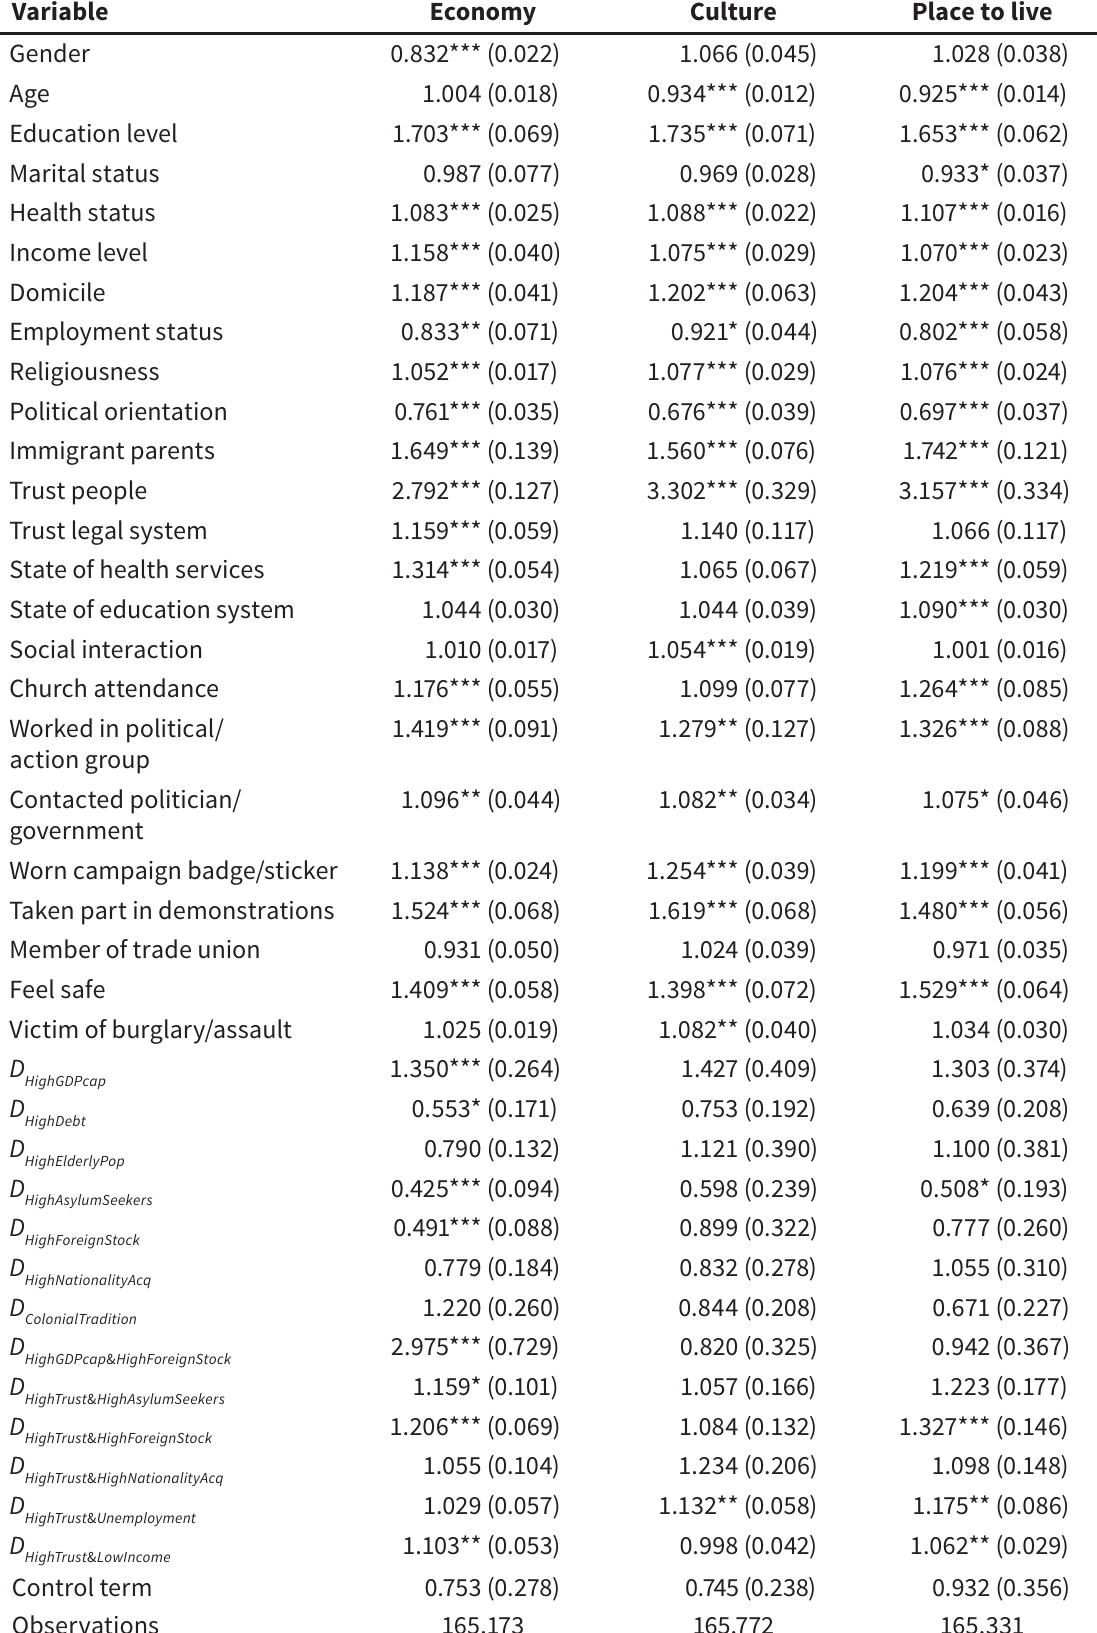
Estimates of Europeans’ attitude toward immigrants (odd ratios)